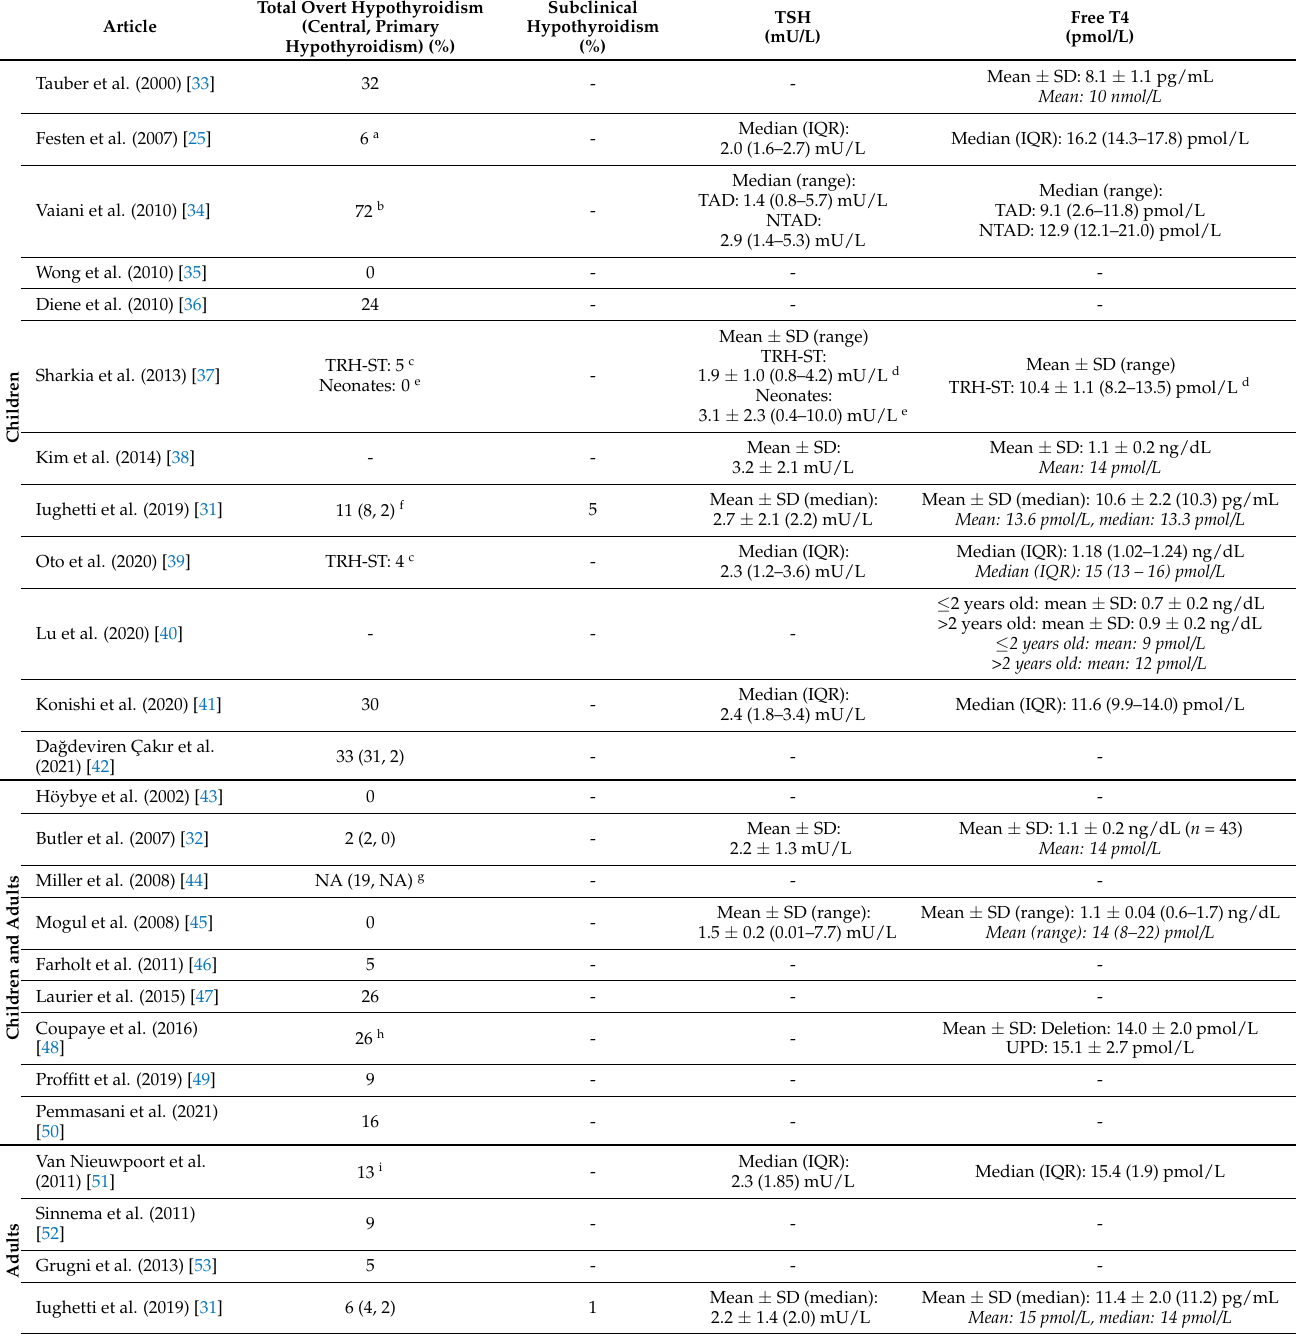
Table 6. Patient characteristics of cohorts assessed by previous studies (Part